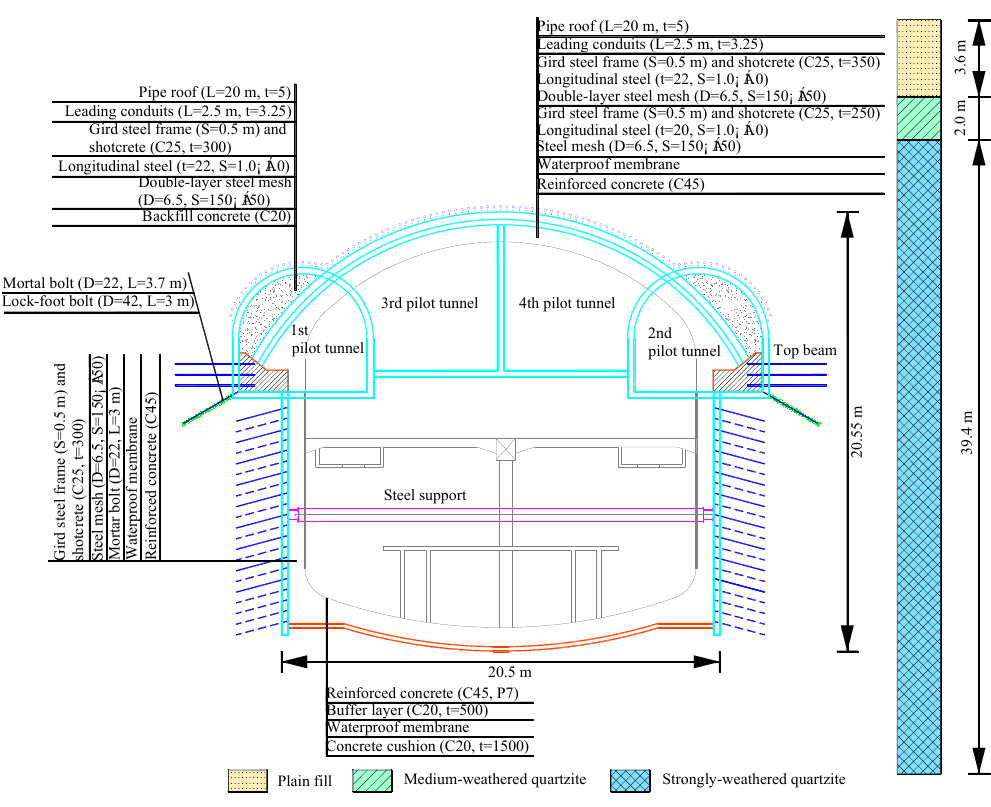
Figure 1. Plan view of Shi Kui Subway Station.